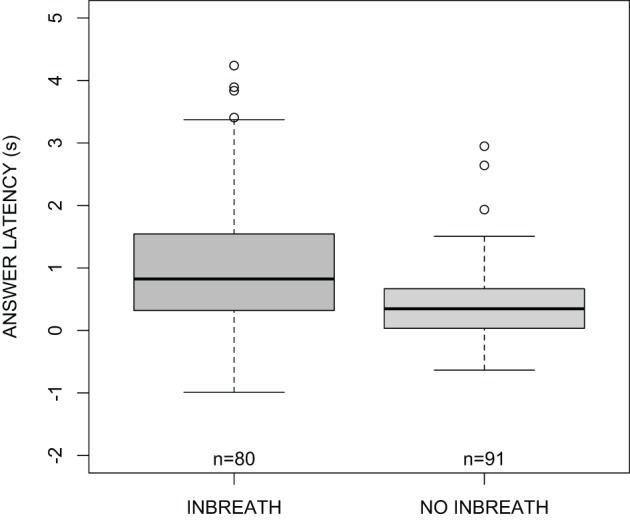
Boxplots of answer latency (s) as a function of the presence of a pre-utterance inbreath.